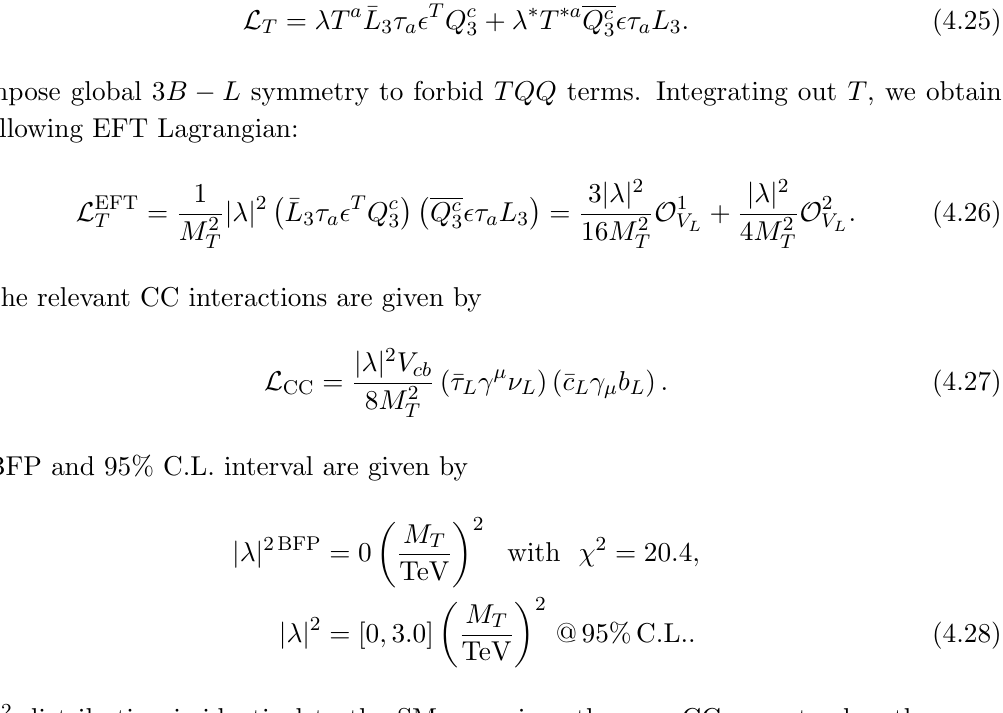
Figure 2. S (cid:24) (3 ; 1) couplings at 95% C.L. for M S = 1 TeV. Red region corresponds to (cid:0) 1 = 3 (cid:21) 1 (cid:21) 2 < 0 and blue region corresponds to (cid:21) 1 (cid:21) 2 > 0. Colored lines are contours of R (2 S ) 4.5 T (cid:24) (3 ; 3) (cid:0) 1 =